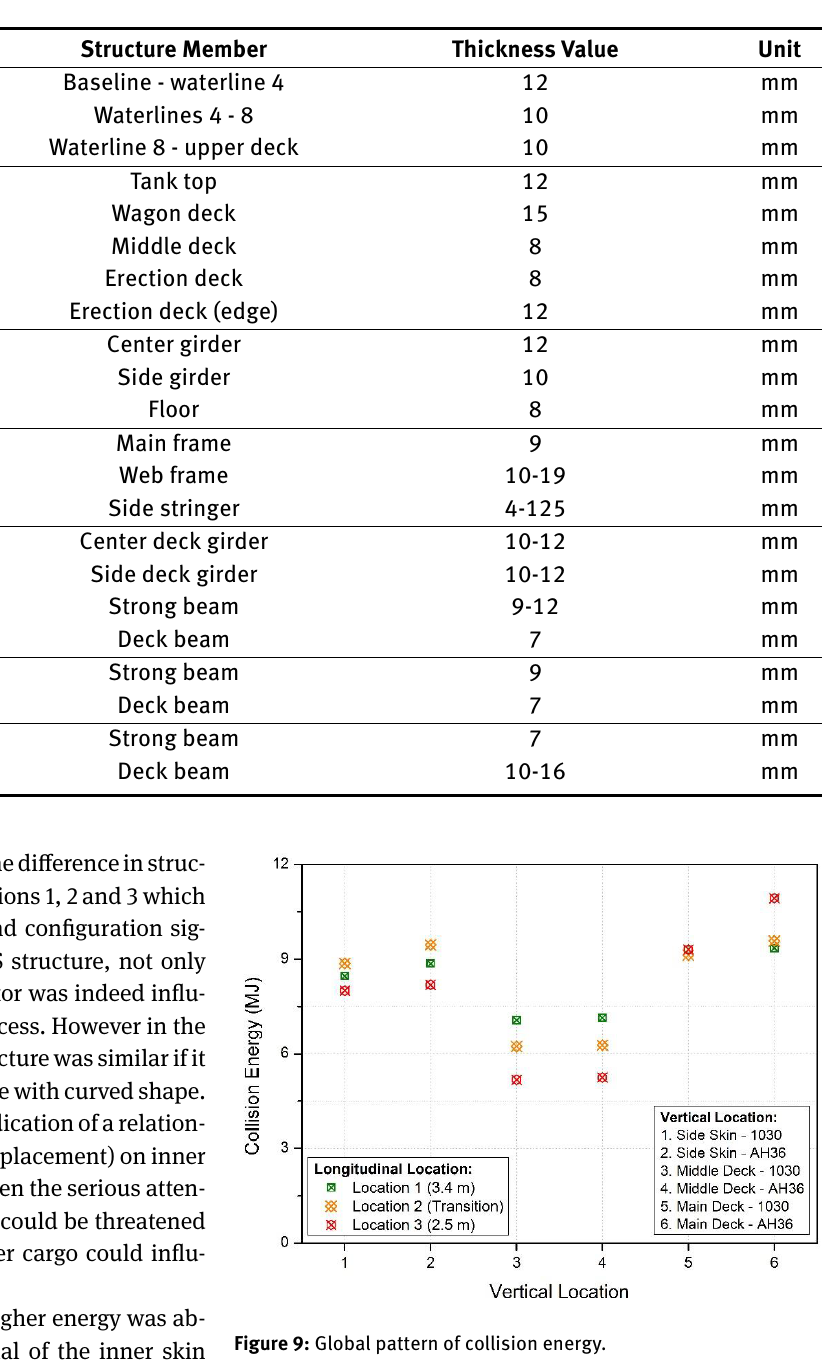
Table 5: Thickness of structural components.